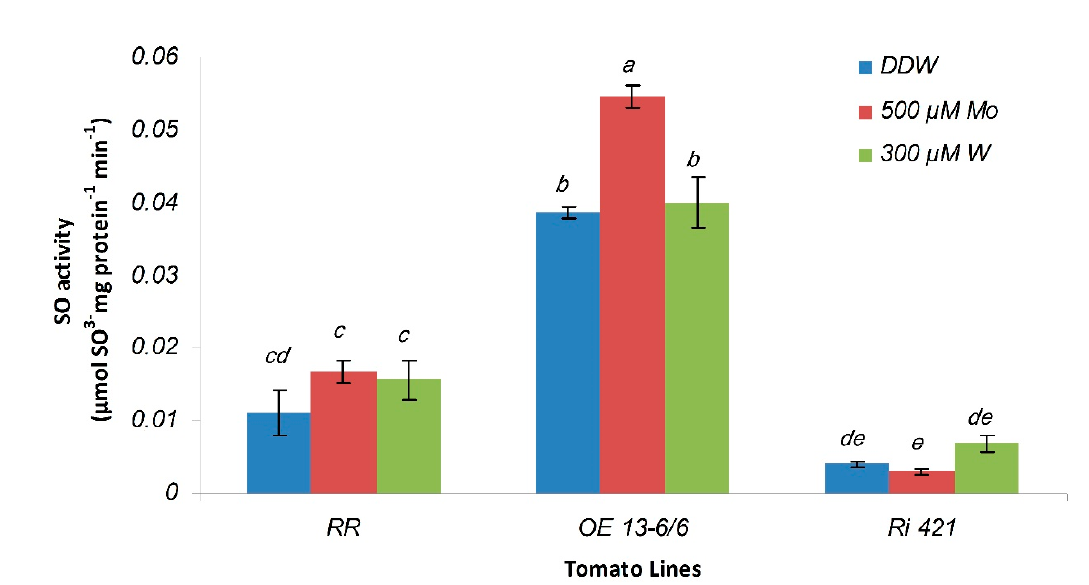
Figure 9. E ff ect of DDW, molybdenum and tungsten pretreatment on SO enzyme activity in wild type and SO modified tomato lines. Leaves from wild type (RR), SO OE (OE 13-6 / 6) and SO Ri (Ri 421) tomato lines were incubated in DDW, 500 µ M Mo or 300 µ M W for 24 h. SO enzyme activity